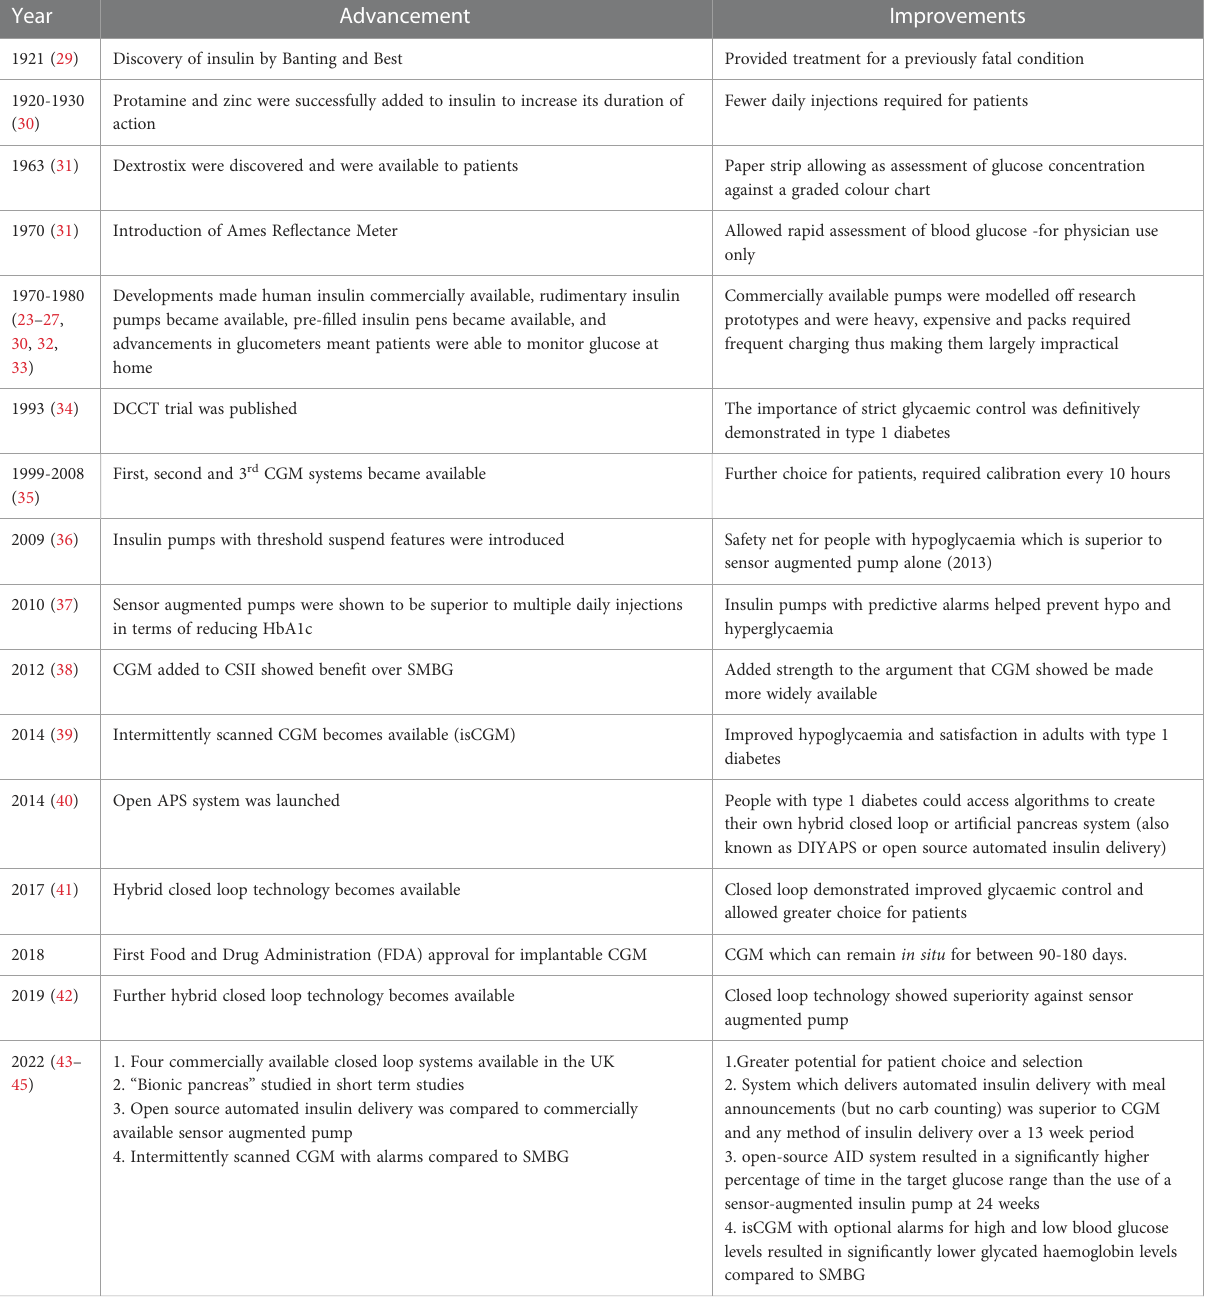
TABLE 1 Advances in diabetes technology for non-pregnant adults with type 1 diabetes mellitus.